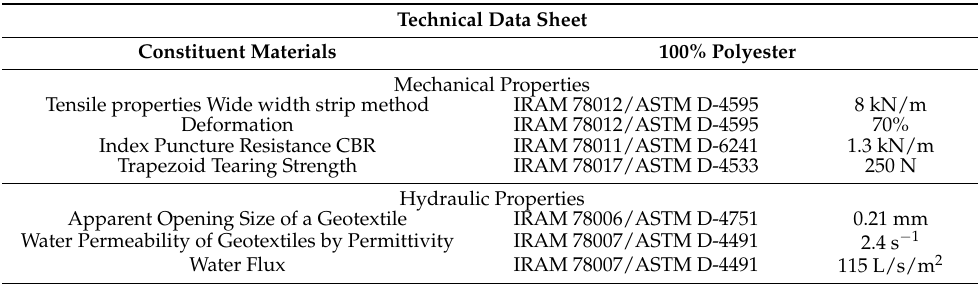
Table A2. Technical Data Sheet of woven Geotextile 150 of Polyester.